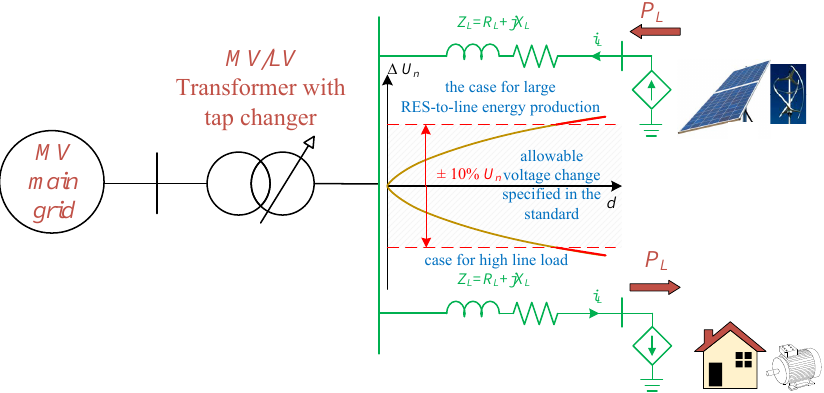
Figure 1. Influence of the line impedance in the low-voltage network on the voltage profile for lines with high Renewable Energy Sources (RES) penetration and for lines with high